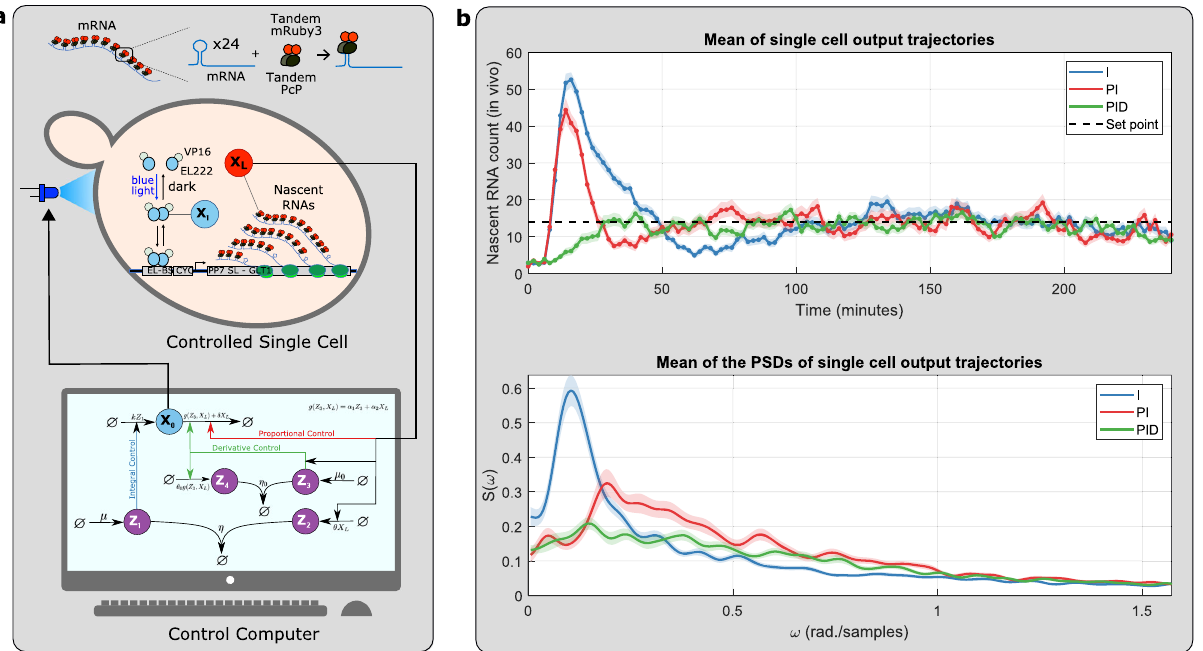
Fig. 9 Experimental demonstration of the performance of a PID controllers in the cyberloop platform 32 with a transcription circuit in Saccharomyces cerevisiae . a A Cyberloop implementation of the fourth-order a PID controller. Using an optogenetic framework proposed in 32, 54 , an in silico stochastic simulation of the proposed fourth-order a PID controller (one controller per cell) is interfaced with a real biological circuit/plant (in vivo) genetically engineered in Saccharomyces cerevisiae cells placed under a microscope. The circuit includes a blue light optogenetic tool allowing light-stimulated regulation of transcription, making nascent RNAs ( X L ) as the output of interest to be controlled. These nascent RNAs (fused with fl uorescent proteins) can be quanti fi ed via fl uorescence imaging under the microscope and subsequent image processing in the control computer. The single-cell nascent RNA measurements are used to simulate stochastic dynamics of the controller network for each cell. Besides controller species ( Z 1 , Z 2 , Z 3 and Z 4 ), an additional in silico plant species X 0 was added to the network to facilitate implementation of proportional and derivative control reactions. X 0 acts as an actuation species whose abundance de fi nes the blue light intensity that the corresponding cell is then stimulated with using a custom-built projector setup 54 attached to the microscope. This setup allows one to stimulate and observe multiple cells in parallel. The single-cell measurements, controller simulations, and blue light intensity updates are done every 2-min interval. b The top plot shows the mean temporal response with the I controller, the PI controller and the fourth-order PID controller. The shaded region represents mean±standard error. This plot demonstrates the effectiveness of the PI controller in reducing the oscillations of the mean response across the cells. It also demonstrates the added bene fi t of the PID controller in reducing the overshoot as well. The bottom plot shows the mean power spectral density (PSD) of various responses. The shaded region represents mean±standard error. The PSD is useful in uncovering the stochastic oscillations on the single-cell level: a sharp peak in the PSD reveals the persistence of stochastic single-cell oscillations. The plot demonstrates the effectiveness of the PID controller in smoothing out the peak and thus considerably reducing the single-cell oscillations. Two separate experiments were performed per controller to track in total 168 cells for the I controller, 128 cells for the PI controller and 178 cells for the PID controller. The experimental parameters are provided in Supplementary Table 3. Source data are available in the Source Data fi